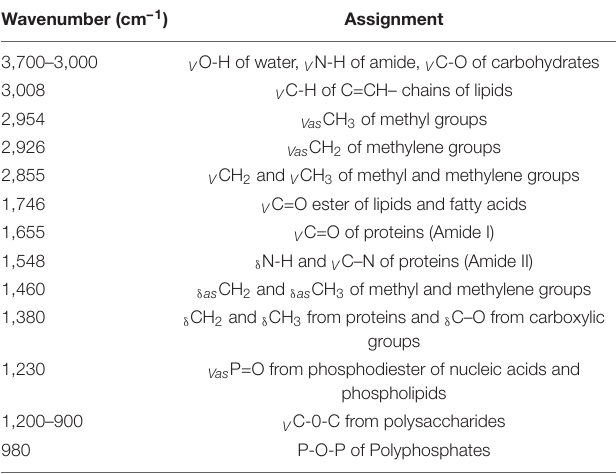
TABLE 1 | Band assignment and functional groups of a typical spectrum of P. tricornutum